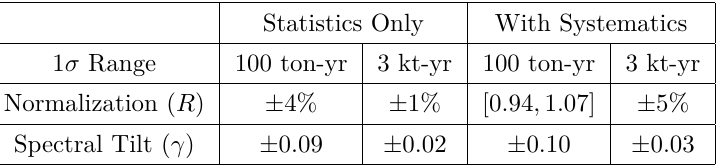
Table 2. Expected measurement capability of the normalization R and spectral tilt γ for the charged-current ν e Ar scattering cross section, with different assumptions regarding exposure and systematic uncertainties. See text for more detail. figure 7 where the left (right) panel corresponds to the statistics-only (5% systematics) analysis. The black (blue) contours correspond to the smaller (larger) exposure. In each case, dashed and solid lines correspond to ∆ χ 2 = 5 . 99 and ∆ χ 2 = 9 . 21 ,